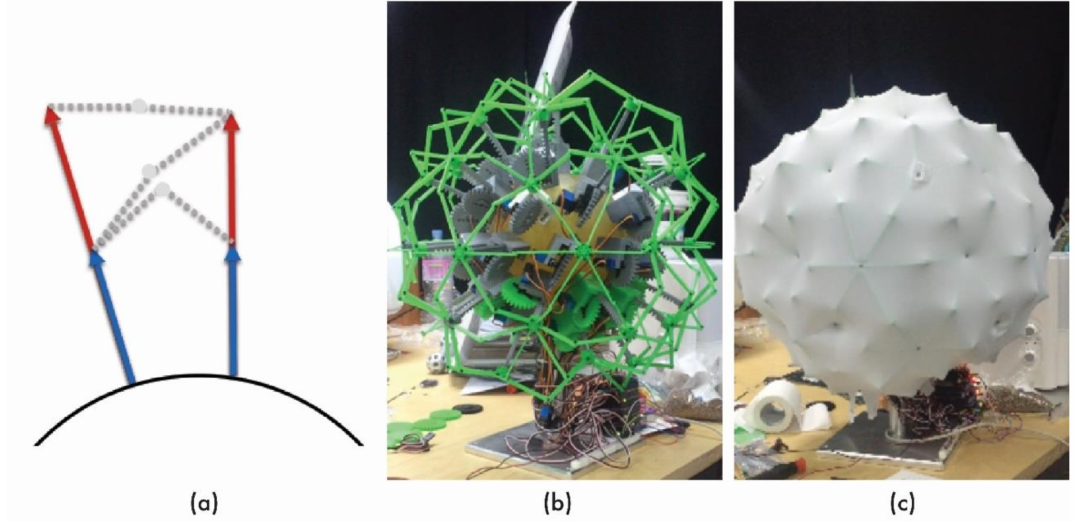
Figure 12. Approach to connect the tip of each actuator to a scissor-hinge to maintain the distance between actuating pins: ( a ) working concept of the scissor-hinge (gray), ( b ) internal structure with scissor-hinge, and ( c ) with the Lycra screen.